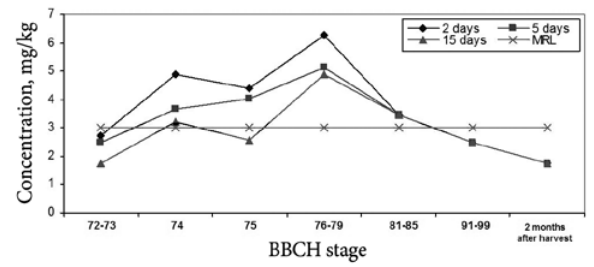
Fig. 15. Degradation of propagite in Jonathan